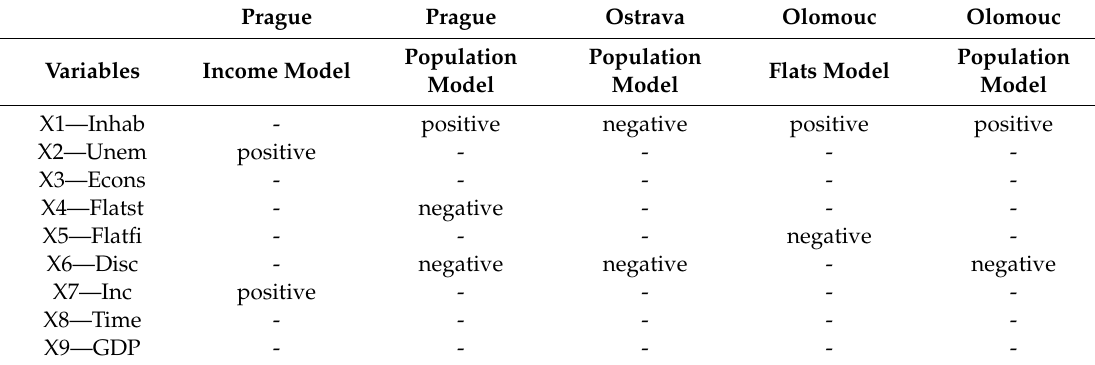
Table 6. Comparison of Prague, Ostrava, and